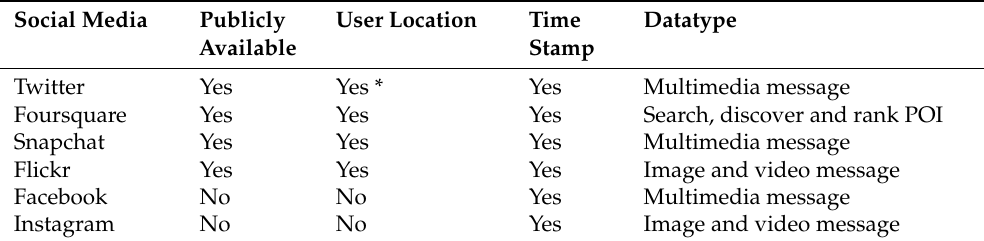
Table 1. Different social media data sources along with their availability and type of data. Columns show if the data source is publicly available or not and if it contains user location, along with the timestamp. * Twitter users can currently decide at which spatial granularity they provide location data or can decide to provide no geo-location information at all. These data are accessible through the Twitter researcher